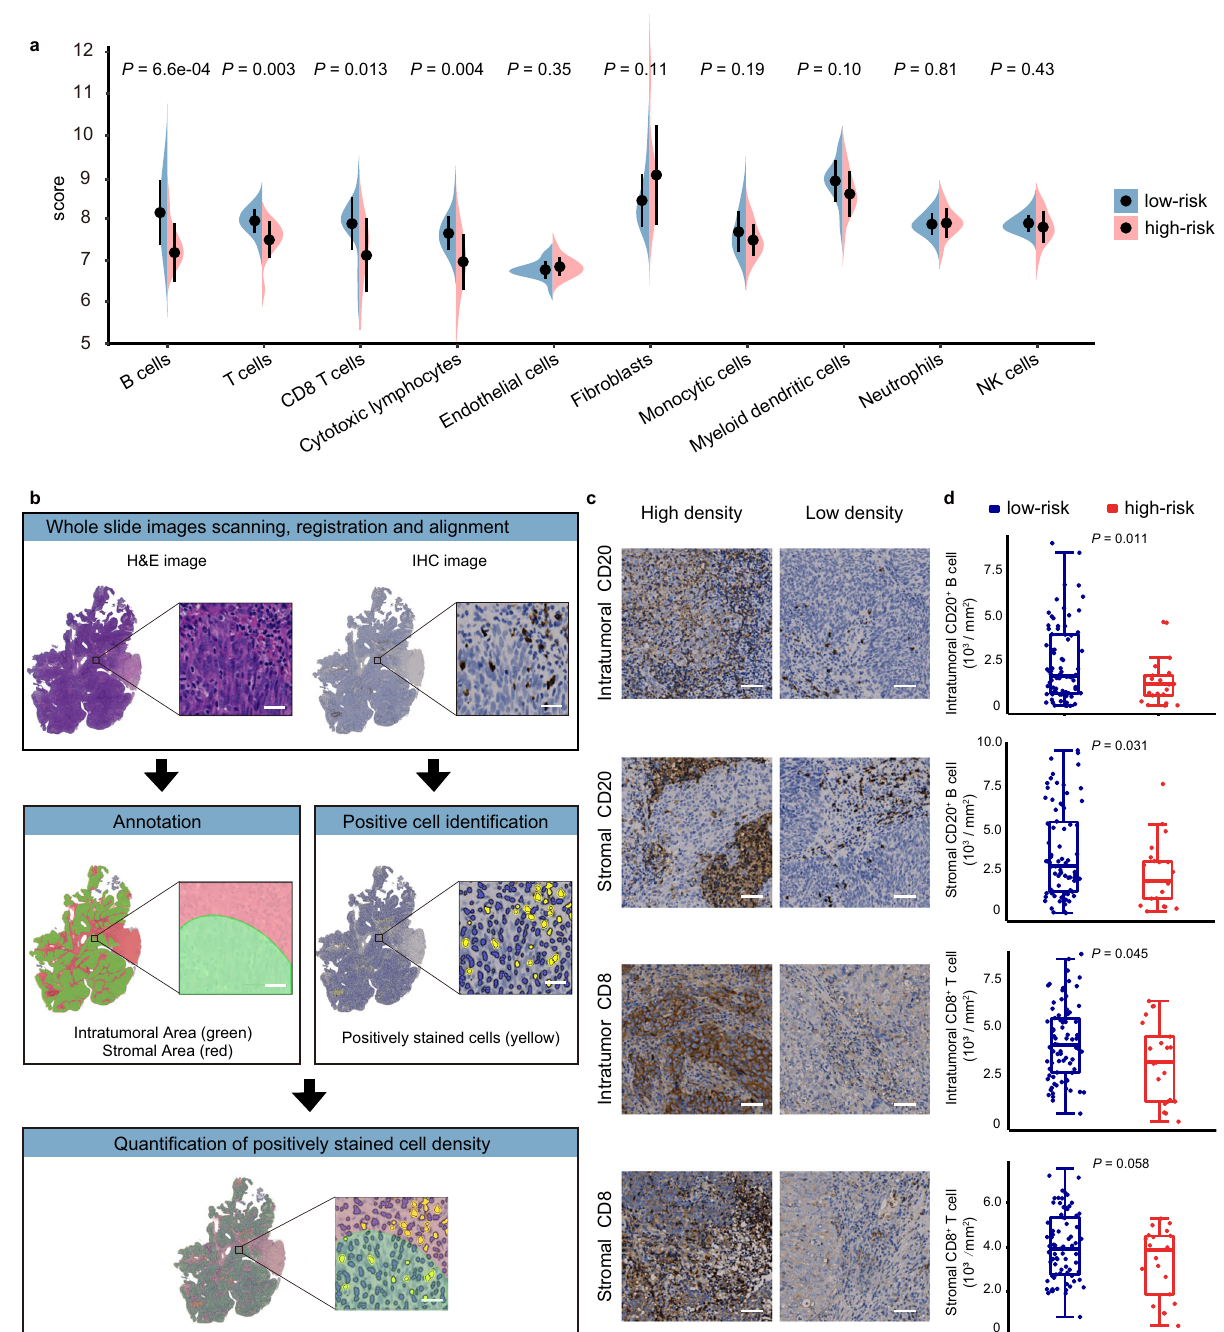
Fig. 6 Immune in fi ltration of high-risk and low-risk groups. a Immune in fi ltration of patients (high-risk, n = 13; low-risk, n = 25) estimated by the MCP- counter algorithm. The dots represent the mean scores, and the error bars represent the standard deviation. The comparison was based on Student ’ s two- sided t -test. b Digital pathology analysis pipeline. For each sample, hematoxylin and eosin (H&E) and immunohistochemistry (IHC) slides were scanned, registered, and aligned in HALO software. Manual annotation of tumor nests and stroma areas on the H&E image were automatically synchronized to the IHC image. Positively stained cells in the IHC images were identi fi ed by the Multiplex IHC algorithm. Quanti fi cation of positively stained cells and the areas of tumor nests and stroma were automatically generated by HALO software. The scale bar represents 25 μ m. c Representative images of CD20 and CD8 expression in intratumoral and stromal areas of tumor sections detected by IHC analysis in the high-risk ( n = 21) and low-risk groups ( n = 78). The images show high (left panel) or low (right panel) CD20 + B and CD8 + T cell densities in intratumoral and stromal areas, respectively. The scale bar represents 50 μ m. d Comparison of CD20- and CD8-positive cells in intratumoral and stromal areas in patients in the high-risk ( n = 21) and low-risk groups ( n = 78) strati fi ed by the nine-lncRNA signature. In each box plot, the centerline represents the median, the bounds represent the fi rst and third quartiles and whiskers extend from the hinge to the largest value no further than 1.5 * interquartile range (IQR) from the hinge. Each dot represents a data point for individual patients. The comparison was based on Student ’ s two-sided t -test. Source data are provided as a Source Data fi